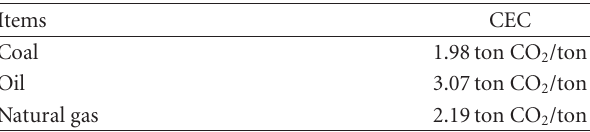
Table 4: The carbon emission coe ffi cients (CEC) for three types of fossil